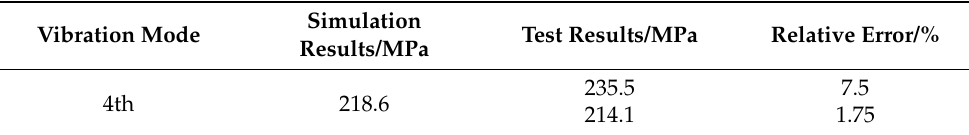
Table 11. Comparison of stress simulation and test results.